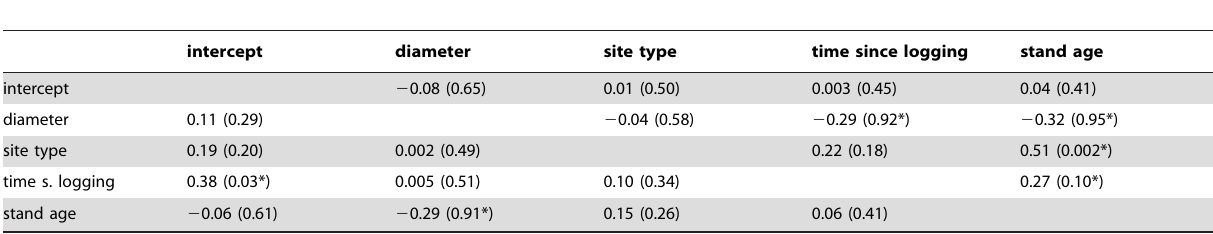
Table 1. Correlations among the species-specific responses to the environmental